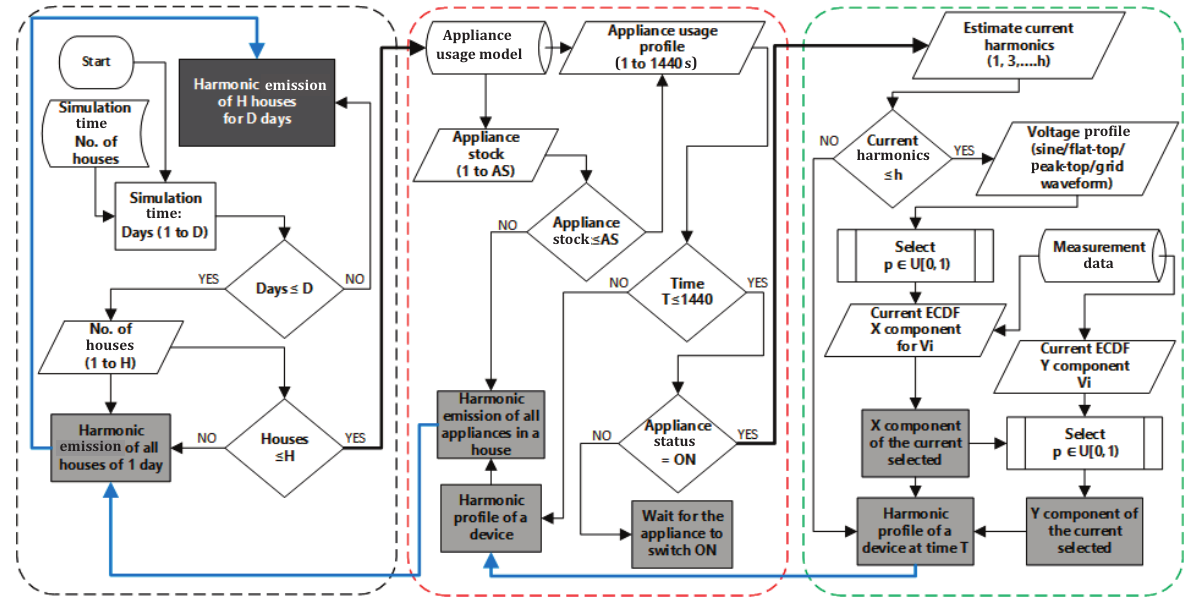
Fig. 4. Flow chart of the proposed